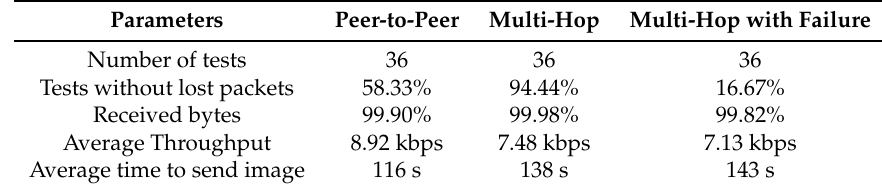
Table 11. Analysis of results obtained in scenario 2.